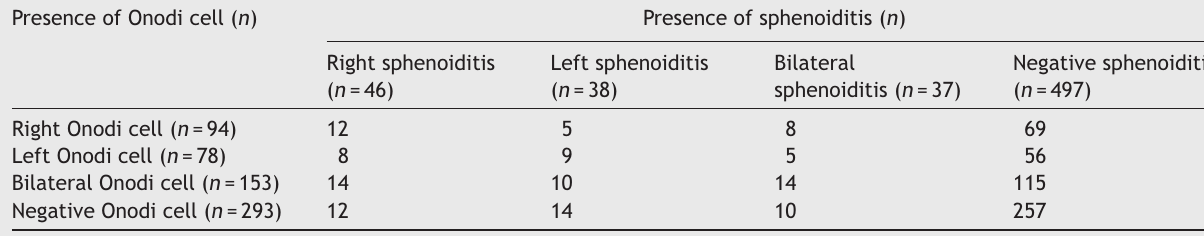
Table 1 Cross tabulation of sphenoiditis and Onodi